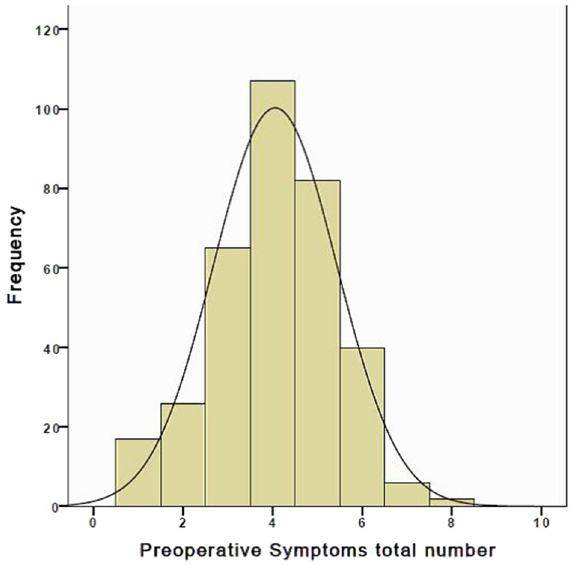
Figure 3. Preoperative total symptoms score (TTS).